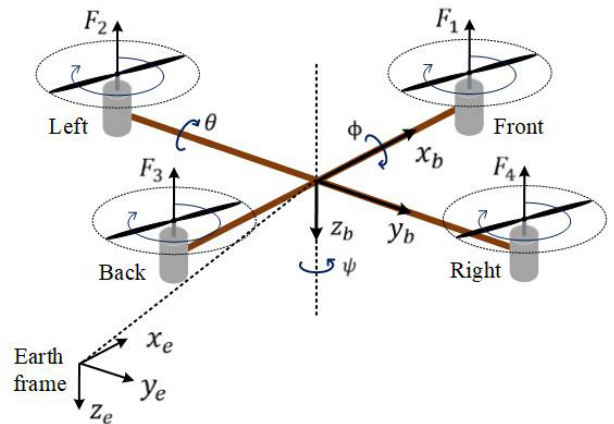
Figure 2. Configuration of a